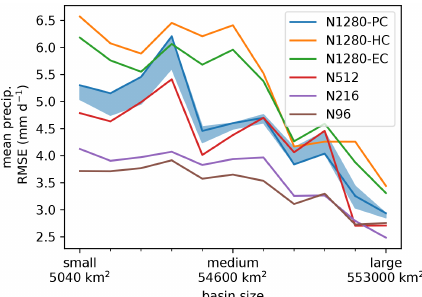
Figure 5. Basin RMSE (Sect. 2.4.4) of each simulation compared to CMORPH shown as a function of basin scale. Light blue shad- ing shows the maximum spread for the three N1280-PC ensemble members. The basin name and median basin size are shown on the x